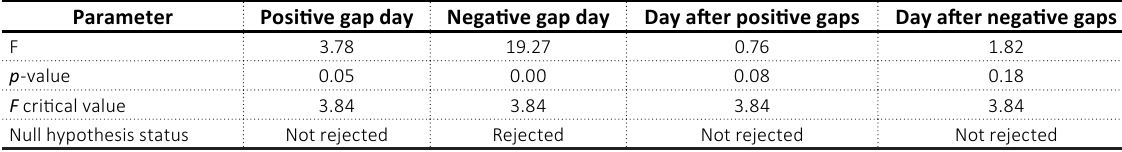
Table A3. ANOVA, the case of the UX index over the period 2009–2018